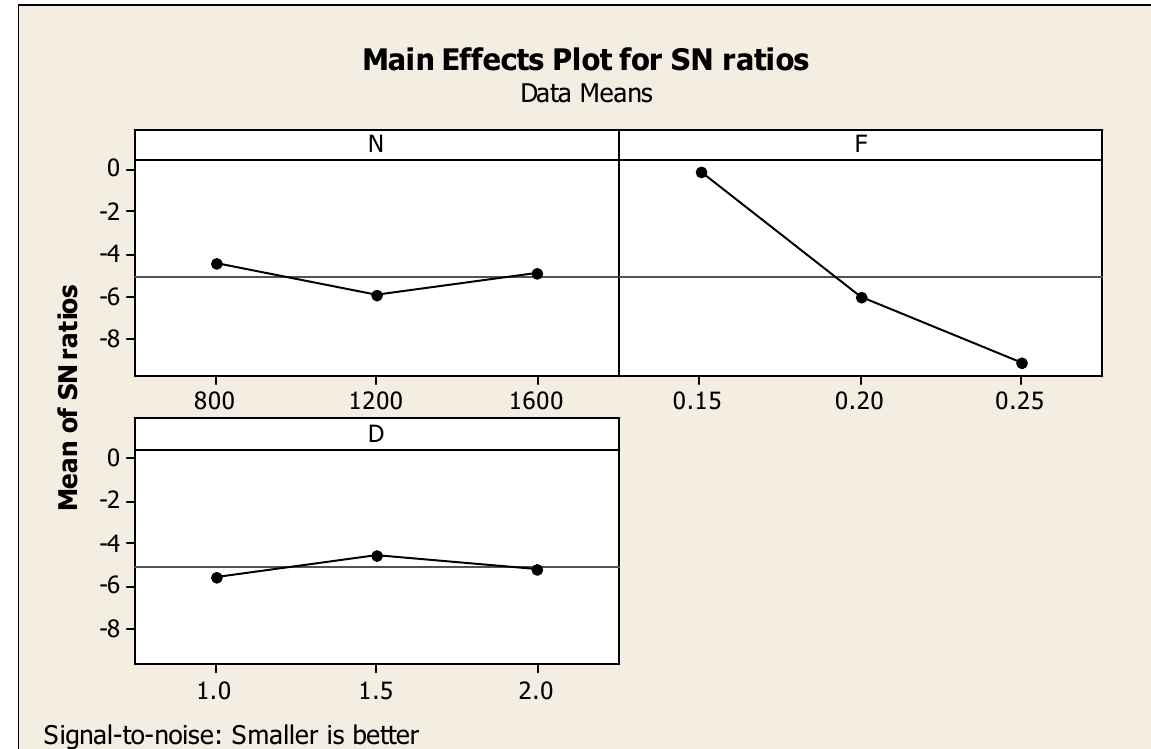
Figure 7. SR major effects diagram.